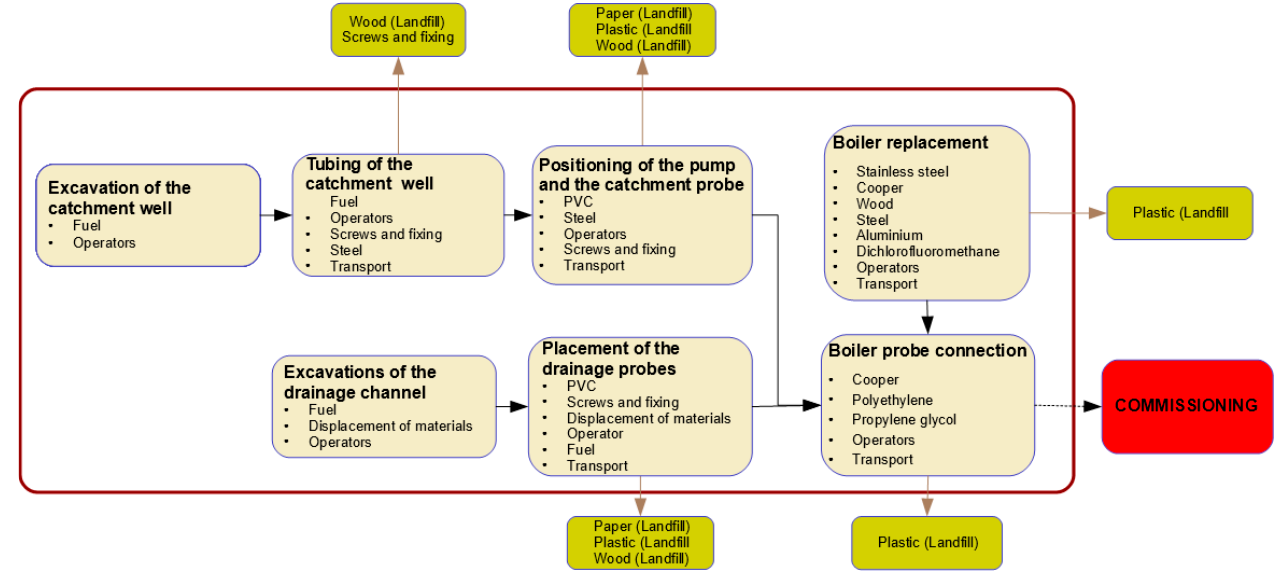
Figure 3. System boundaries for alternative B.